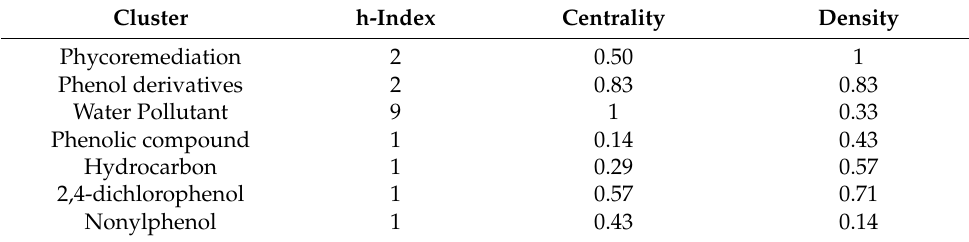
Figure 5. The strategic diagram (outcome) from SciMAT as described by Cobo et al. [30]. Despite being a cluster with low development, “phenol derivative” was observed as significant due to its high centrality (0.83) in the basic theme (Table 1). Hence, “phenol derivative” would be a promising theme in the research study. Table 1. The measures for themes of the first period